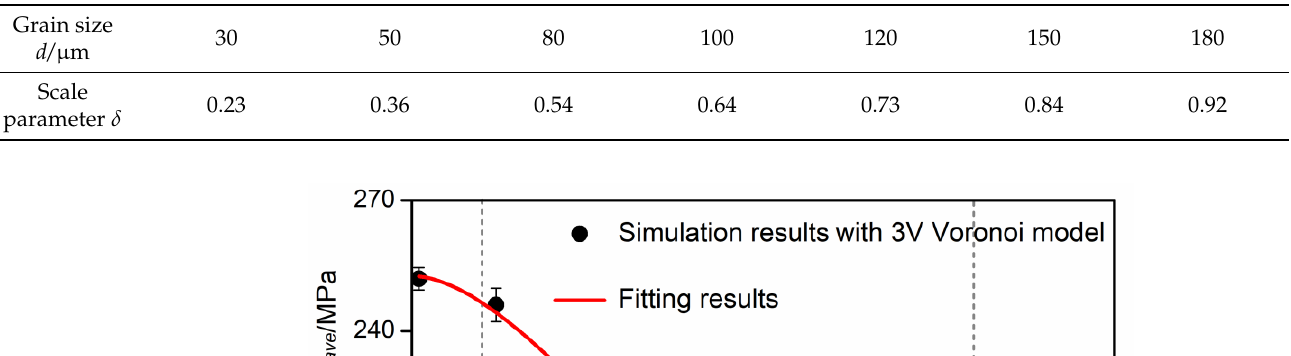
Table 2. Grain sizes and the scale parameters in the micro compression simulation process.